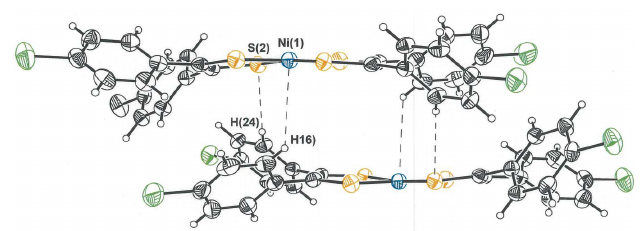
Figure 4 Illustration of the C—H (cid:2)(cid:2)(cid:2) S and C—H (cid:2)(cid:2)(cid:2) Ni contacts that occur between closest pairs of bis[1,2-bis(4-chlorophenyl)ethylene-1,2-dithiolato(1 (cid:5) )]- nickel(II) molecules. Ellipsoids are presented at the 50% probability level. Symmetry operation: (cid:5) x , 1 (cid:5) y , 1 (cid:5) z .